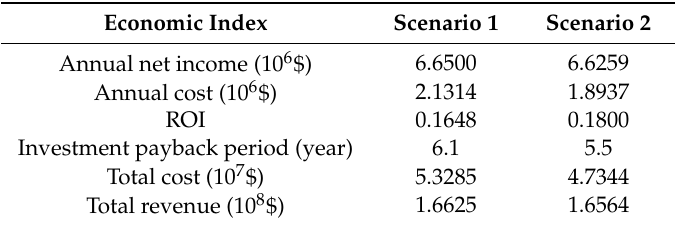
Table 10. Economic index (single-level model).